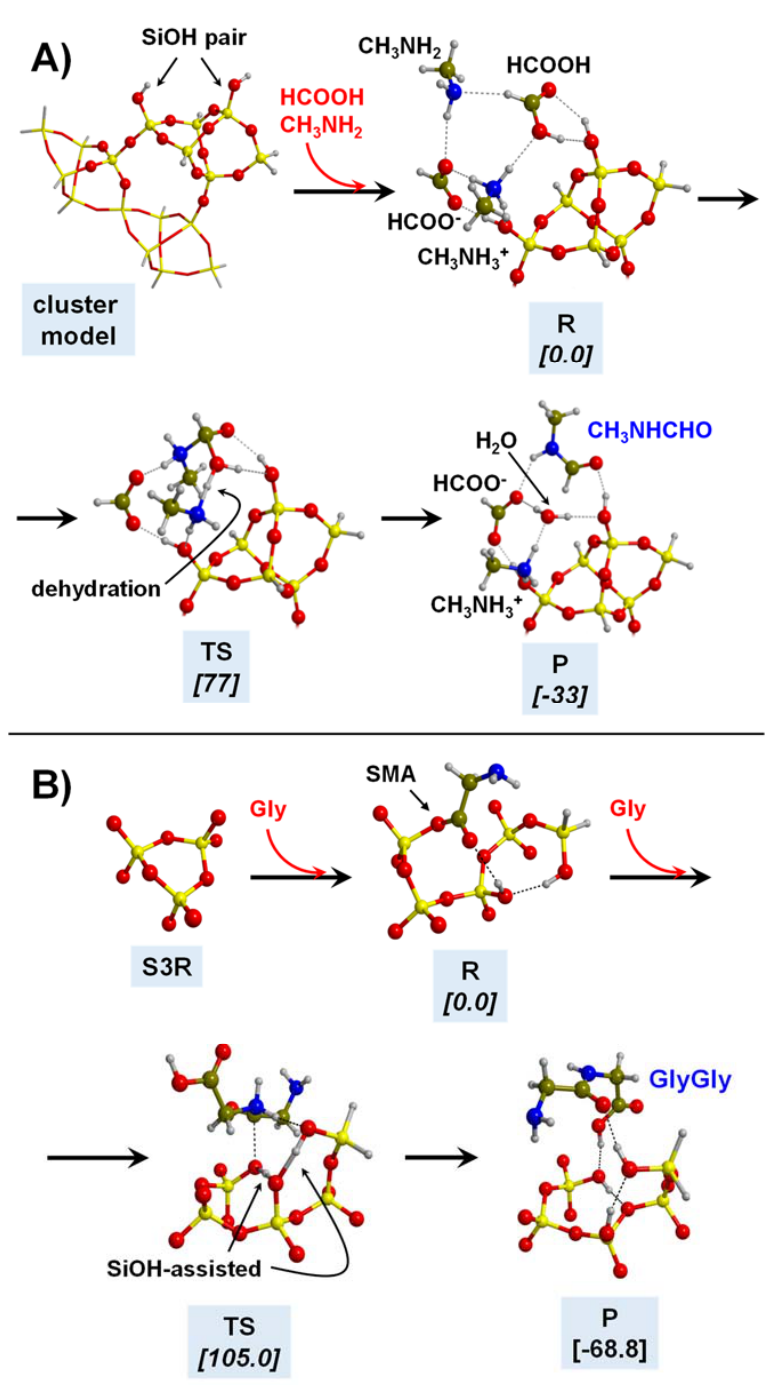
Figure 8. ( A ) Mechanism of the condensation reaction between HCCOH and CH3NH 2 catalysed by silica surface represented by an amorphous cluster model (adapted from Ref. [189]). ( B ) Mechanism of the condensation reaction between two Gly molecules in the presence of the S3R surface defect (see text), in which a surface mixed anhydride (SMA) complex is formed as an intermediate, and the condensation is catalysed by a silanol (SiOH) ‐ assisted proton transfer mechanism (adapted from Ref. [152]). R means the reactants, TS the transition state, and P the product. Values in brackets refer to the energetics of the process in kJ mol − 1 .